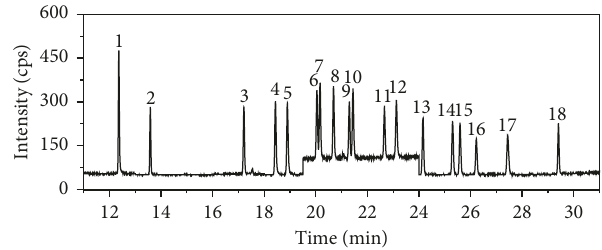
Figure 1: SIM chromatogram of 18 PCB (10 μ g/L) standard so- lutions: peaks 1–18 are PCB28, PCB52, PCB101, PCB118, PCB153, PCB138, PCB180, PCB81, PCB77, PCB123, PCB114, PCB105, PCB126, PCB167, PCB156, PCB157, PCB169, and